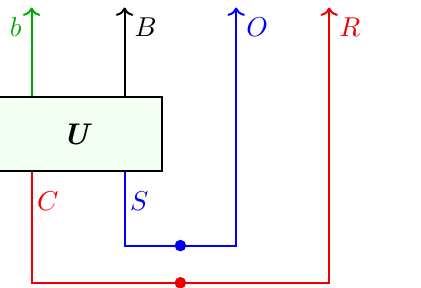
Figure 9. Maximally entangled state of a post-Page time black hole after a period of Hawking evaporation. If U is scrambling and d , the state of the late and early radiation looks like S (cid:29) d b a factorized product state ρ . The reconstruction of the black hole interior must involve the b ⊗ ρ R Hilbert space of the